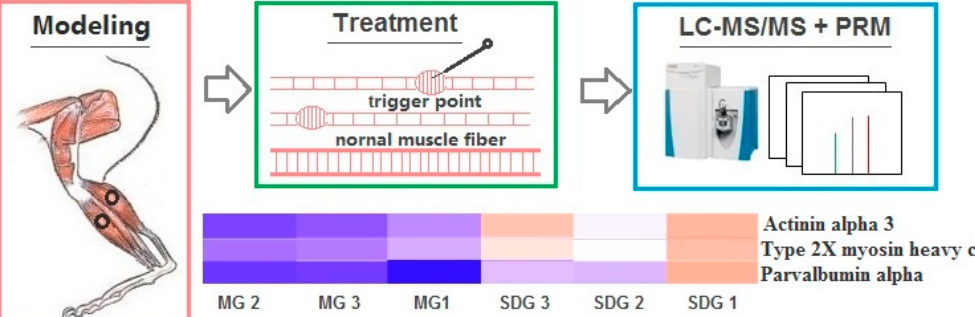
Figure 1. The schematic outline of the experimental workflow.